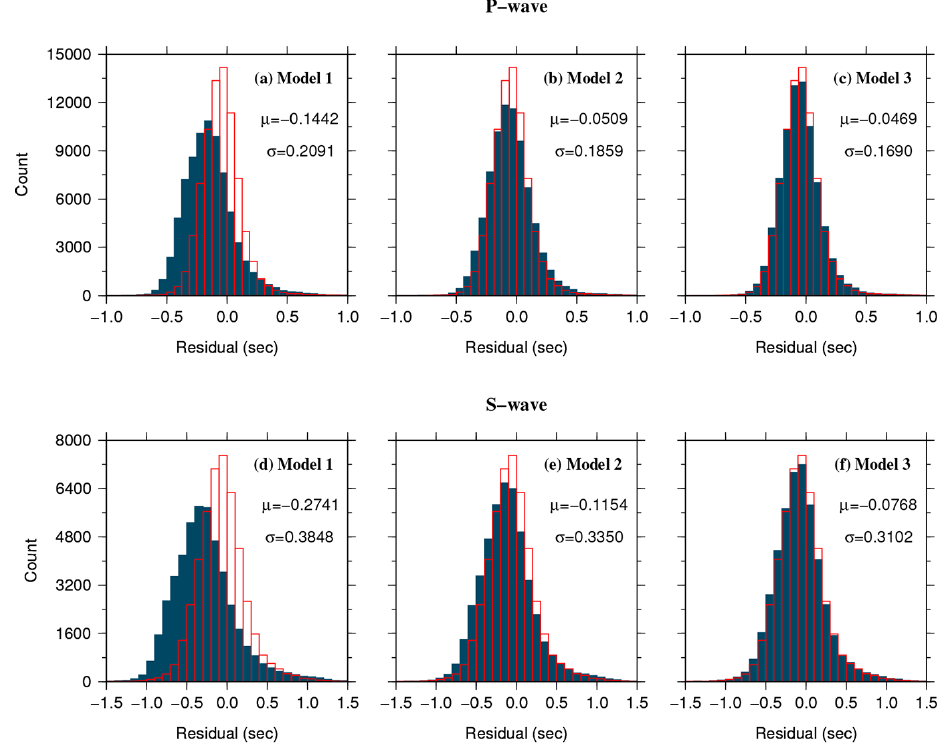
Figure 11. P wave (a–c) and S wave (d–f) travel-time residuals T obs − T syn in models m 1 − m 3 (blue histograms) compared to those in model m 4 (red histograms). The mean µ and standard deviation σ of the travel-time residuals in models m 1 − m 3 (corresponding to blue histograms) are shown in each panel. In m 4 , the mean and standard deviation values of the P wave travel-time residuals are µ = − 0 . 0457s and σ = 0 . 1596s, and those of the S wave travel-time residuals are µ = − 0 . 0652s and σ = 0 .